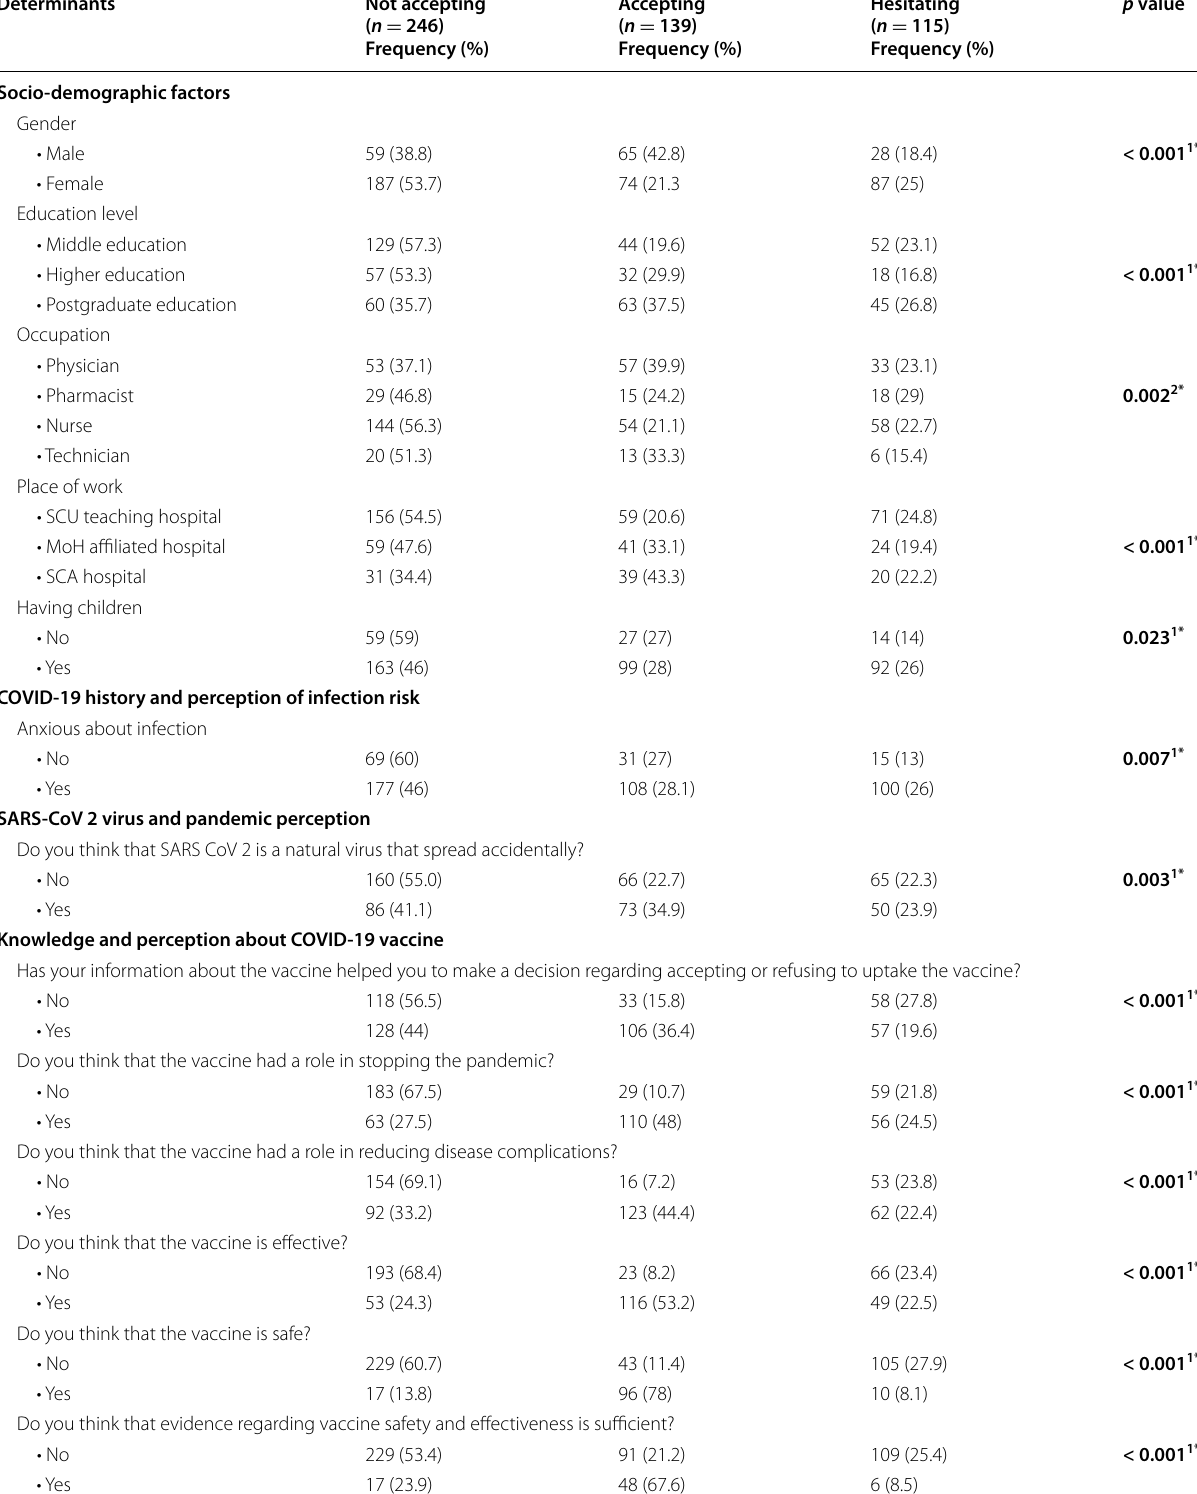
Table 1 Determinants and barriers of COVID‑19 vaccine acceptance among healthcare workers in the studied hospitals according to the state of acceptance and hesitancy to take the vaccine during March and April 2021, Ismailia, Egypt Determinants Not accepting (